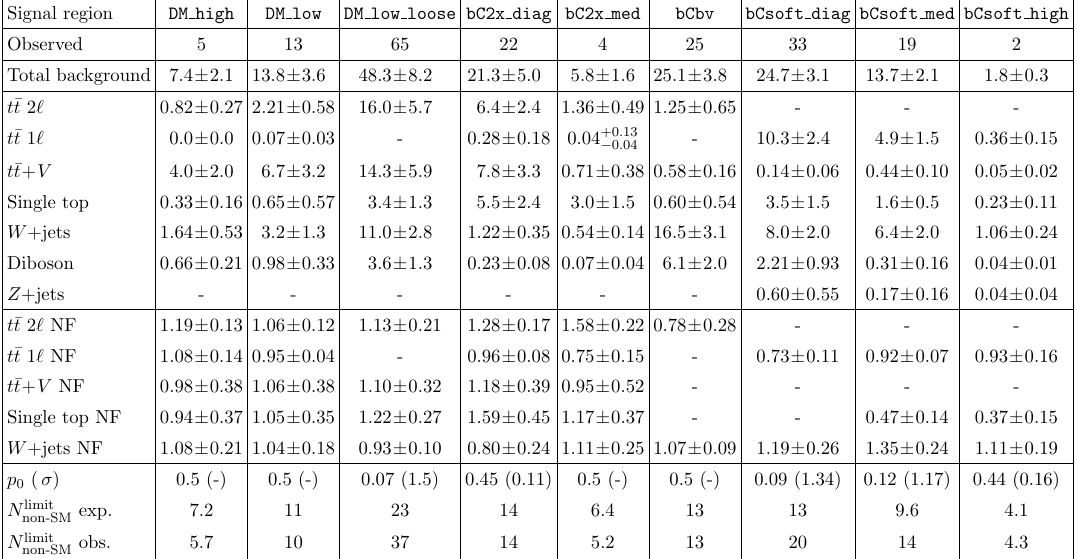
N limit non-SM obs. Table 24 . The numbers of observed events in DM+ t (cid:22) t , wino NLSP, bCbv, and higgsino LSP SRs together with the expected numbers of background events and their uncertainties as predicted by the background-only (cid:12)ts, the normalisation factors (NF) for the background predictions obtained in the (cid:12)t, the probabilities (represented by p 0 values, and capped at 0.5) that the observed numbers of events are compatible with the background-only hypothesis, and the expected ( N limit and observed ( N limit obs.) 95% CL upper limits on the number of beyond-SM events. Some of non-SM the SRs where t (cid:22) t background events are predominantly semileptonic or dileptonic have only one NF which is also applied to the subdominant t (cid:22) t contribution. Backgrounds with no associated NF are normalised with the theoretical cross-sections.